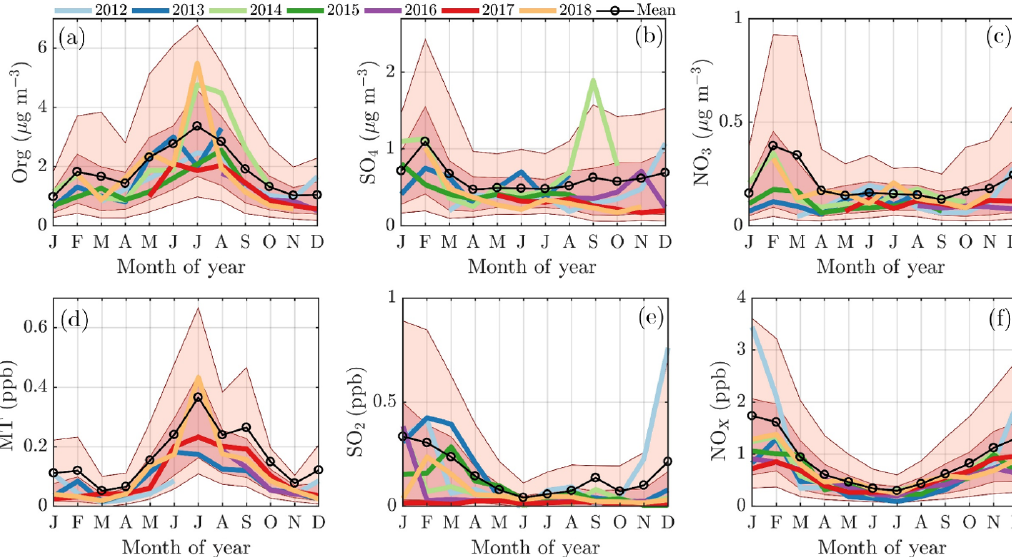
Figure 4. The monthly cycles of organics (a) , sulfate (b) , and nitrate (c) concentrations in the NR-PM 1 and their major precursors, i.e., monoterpenes (d) , sulfur dioxide (e) , and nitrogen oxides (f) . The median monthly concentrations for each year are individually displayed with the solid colored lines. The circled black line represents the overall monthly mean values. The shaded dark red area is drawn between the overall 25th and 75th percentiles, and the shaded lighter red area is drawn between the overall 10th and 90th percentile. The x axes represent the time of the year and the y axes in panels (a) – (c) represent mass concentration inµgm − 3 and (d) – (f) in parts per billion